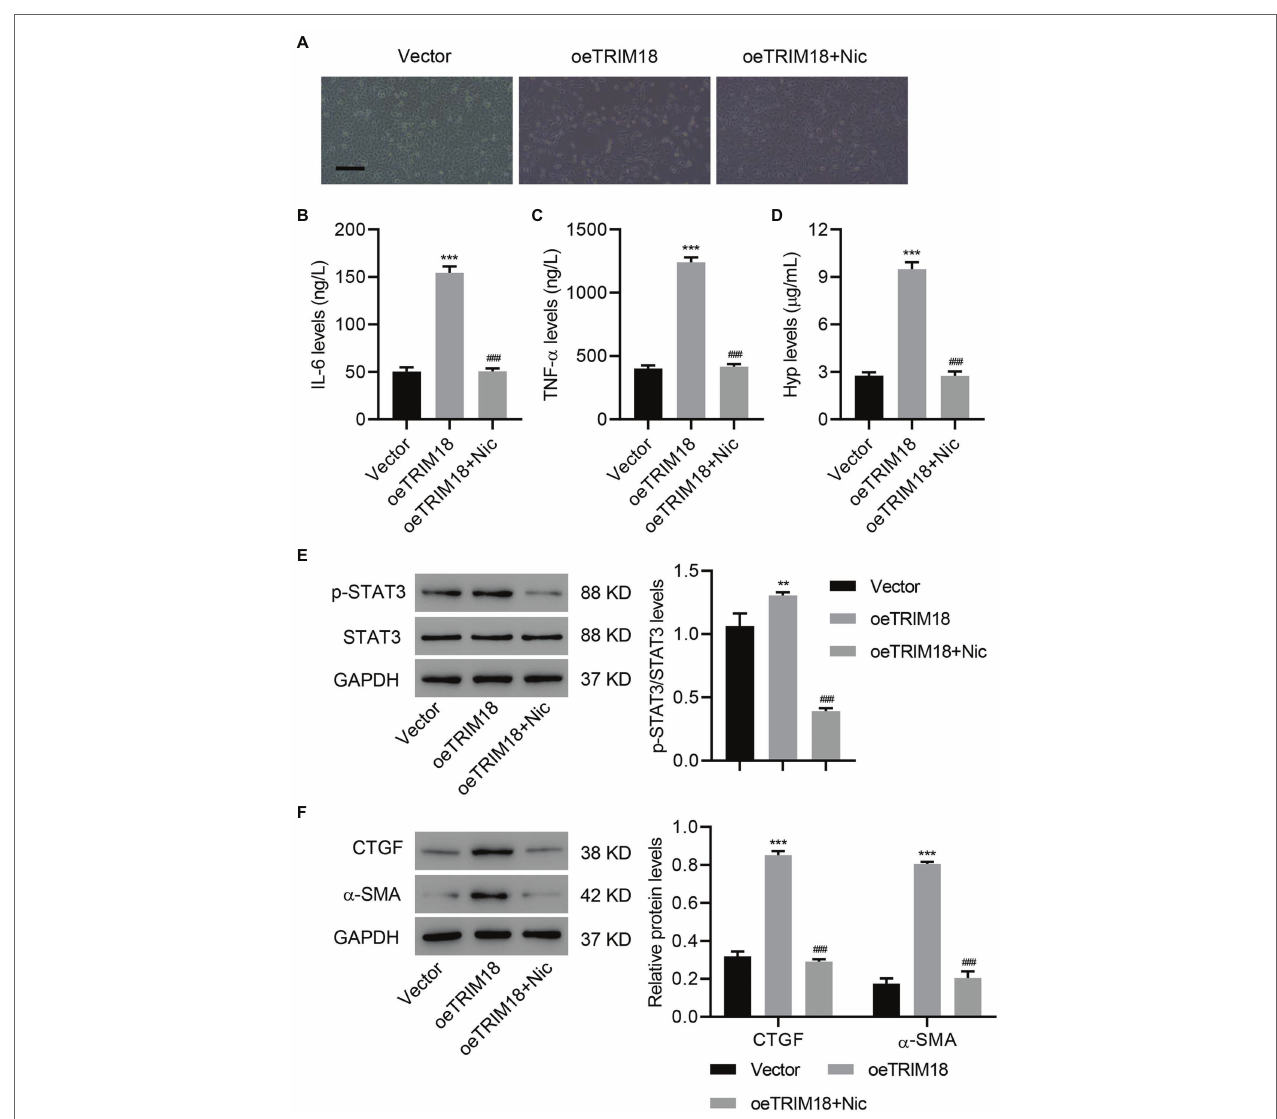
FIGURE 4 | TRIM18 overexpression promotes EMT, inflammation, and fibrosis of HK-2 cells via the STAT3 signaling pathway. HK-2 cells were transduced with the indicated vectors and treated with 10 μ M niclosamide (Nic). The (A) cell morphology, (B–D) levels of Hyp, IL-6, and TNF- α , and (E,F) expression of p-STAT3, CTGF, and α -SMA were measured. Scale bar: 100 μ m. Values are presented as mean ± SD. n = 3/group. ** p < 0.01 vs. vector. *** p < 0.001 vs. vector. ### p < 0.001 vs.